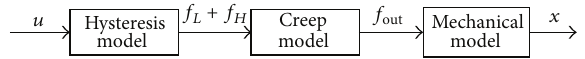
Figure 1: Schematic representation of PSAs.